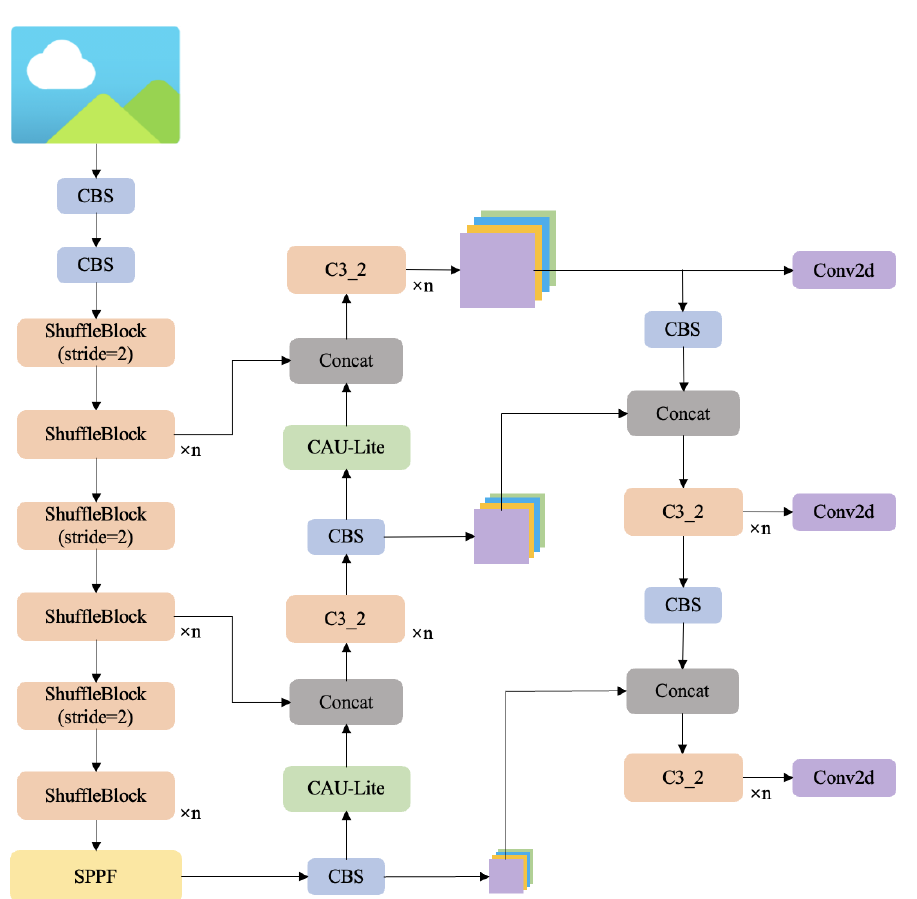
Figure 2. The network structure of Edge-YOLO.